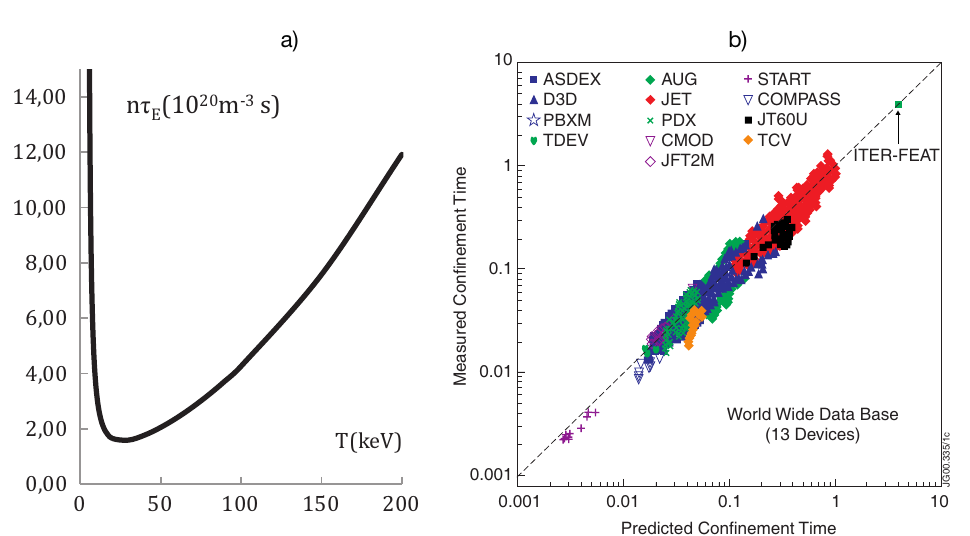
Fig. 3. – (a) Lawson criterion nτ E vs. temperature for a pure homogeneous DT plasma; and (b) measured energy confinement time vs. the prediction of the ITER98y2 scaling (from ref. [9], by courtesy of EUROfusion). ITER-FEAT was the name of ITER at the time of ref.